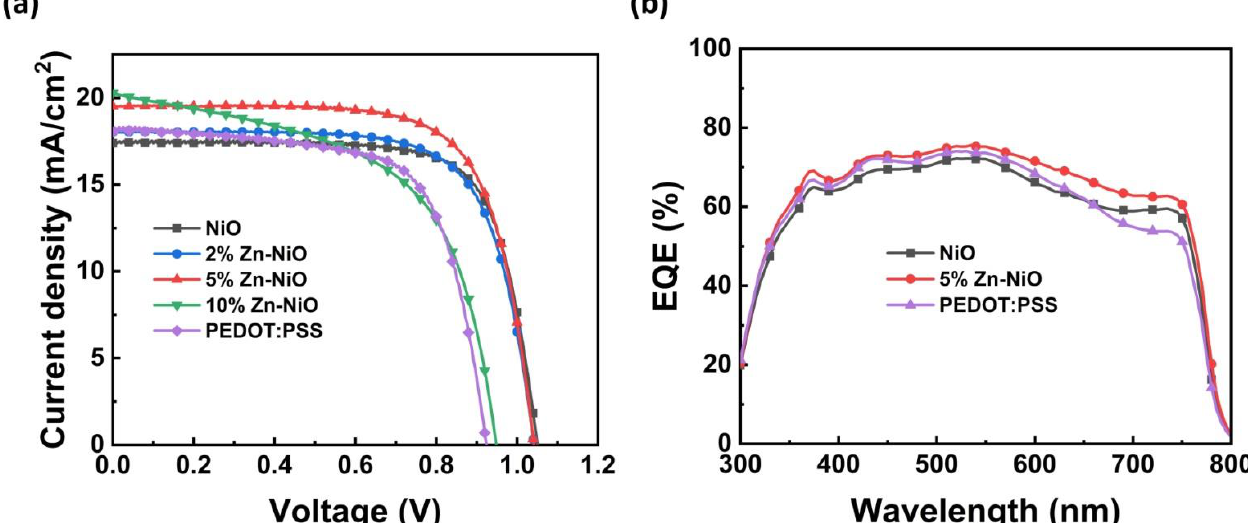
Figure 2. ( a ) J – V characteristics and ( b ) EQE spectra of PSCs made with NiO x , Zn-NiO x , and PEDOT: PSS (control) HTLs.